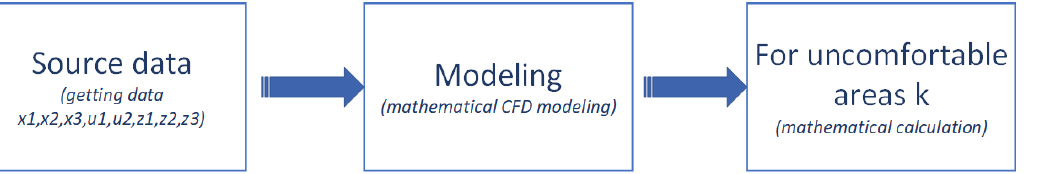
Figure 9. Method of modeling the aeration regime of residential buildings on sloping lands of the Arctic zone of the Russian Federation.